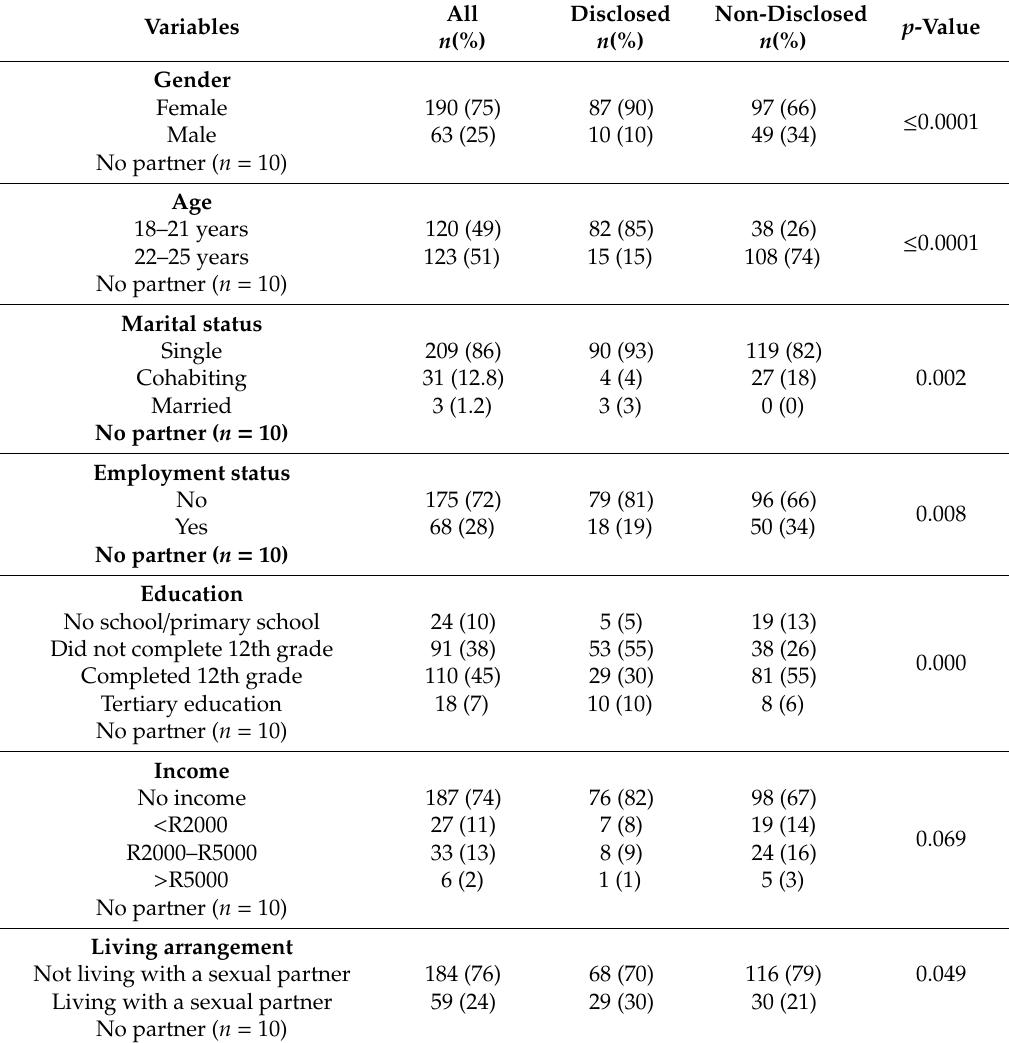
Table 1. Socio-demographic characteristics of youth living with HIV by disclosure status. Variables